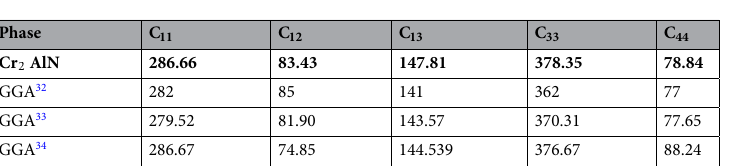
Table 5. The calculated second order elastic constants (in GPa) for hexagonal superconductor Cr 2 AlN for this work in bold. Other theoretical results are also included for comparison.